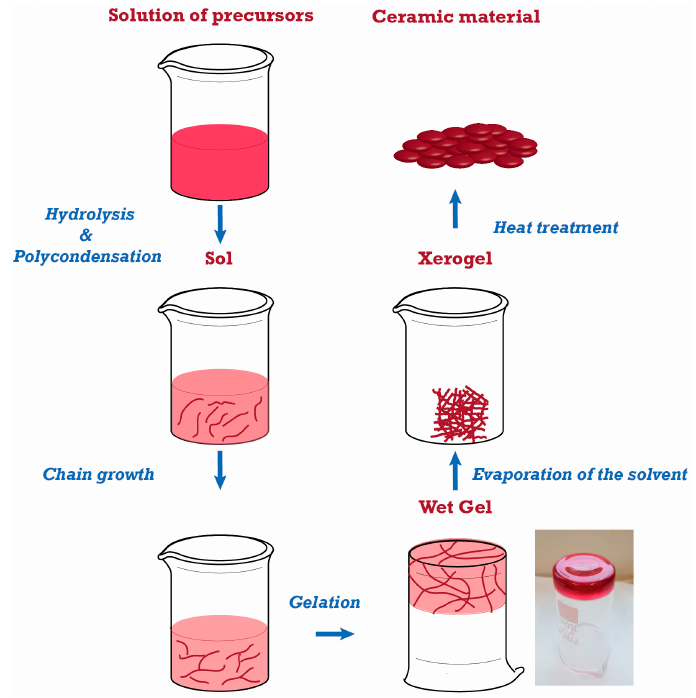
Figure 1. Schematic representation of sol-gel process.